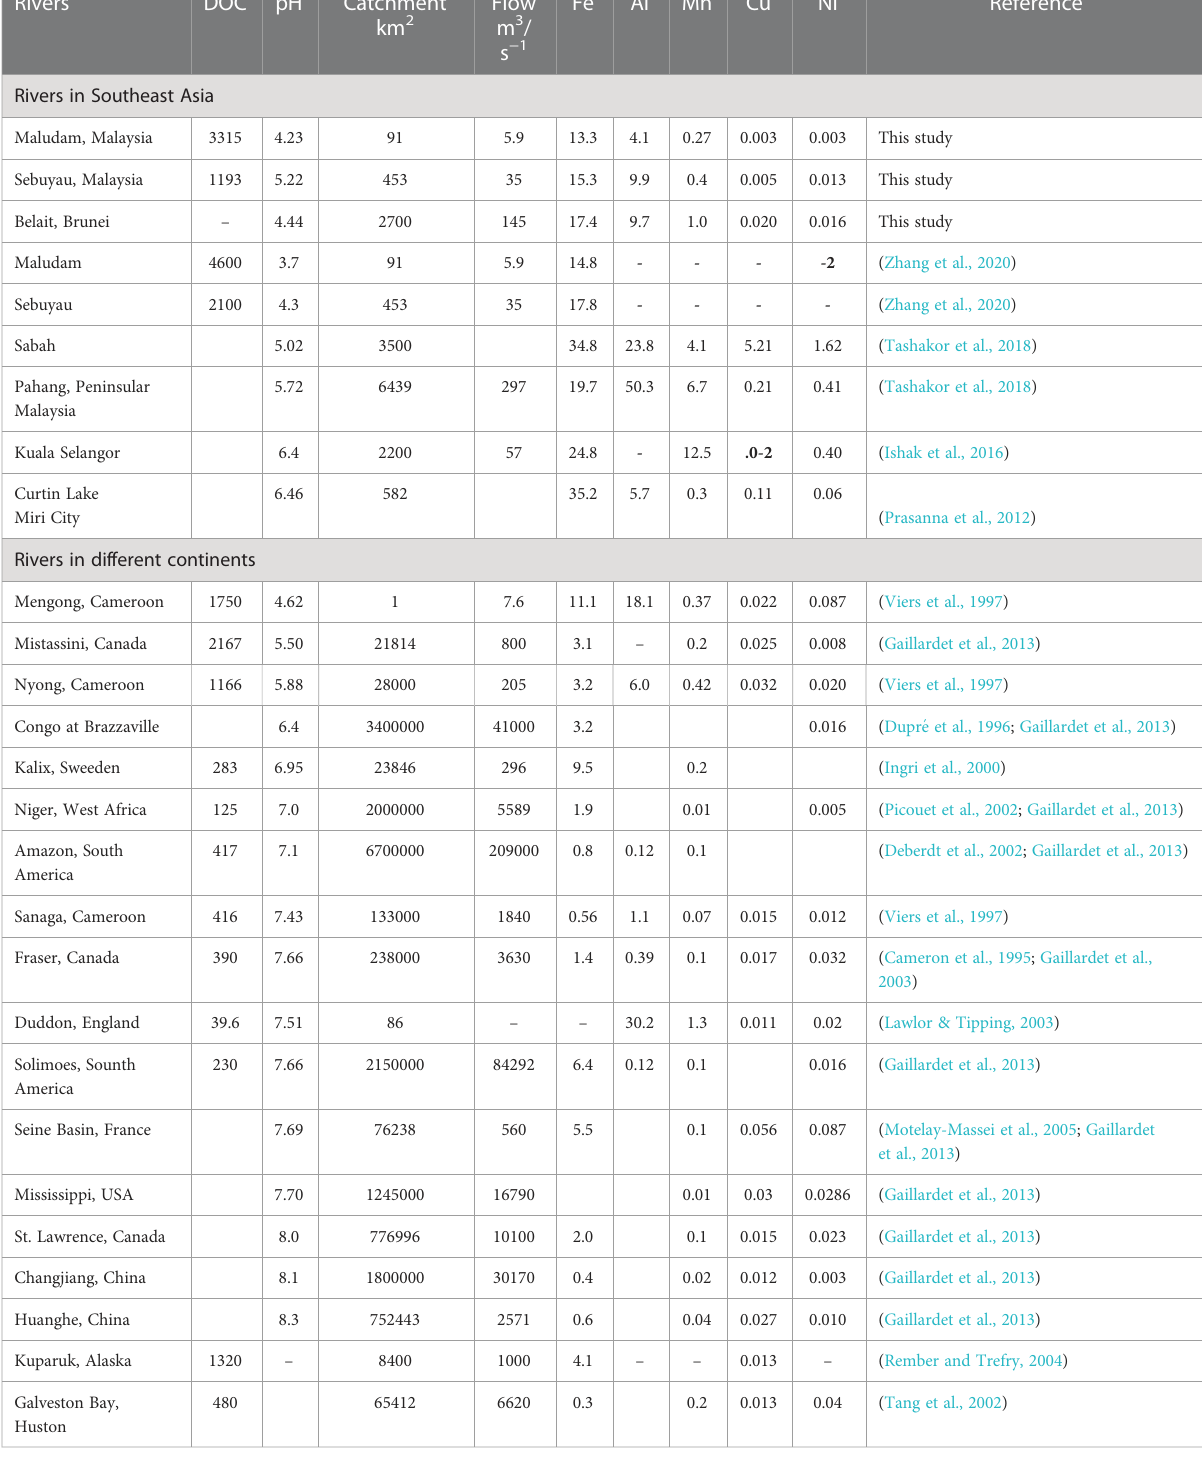
TABLE 5 Concentration of DOC (µmol L − 1 ) and trace elements from Borneo riverine endmember (Maludam, Sebuyau and Belait) compared to studies in Southeast Asia and different continents (µmol kg − 1 ). Rivers DOC pH Catchment km